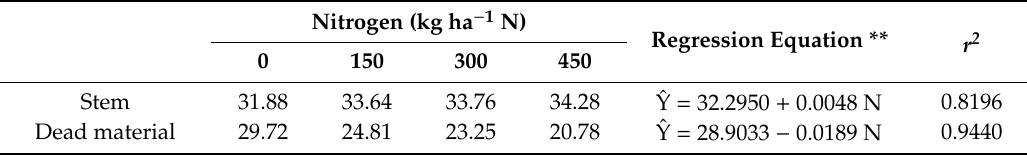
Table 8. Percentage averages of stem and dead material in post-grazing forage mass of Brachiaria brizantha cv. Piatã under rotational stocking and nitrogen fertilization throughout seasons of the year .